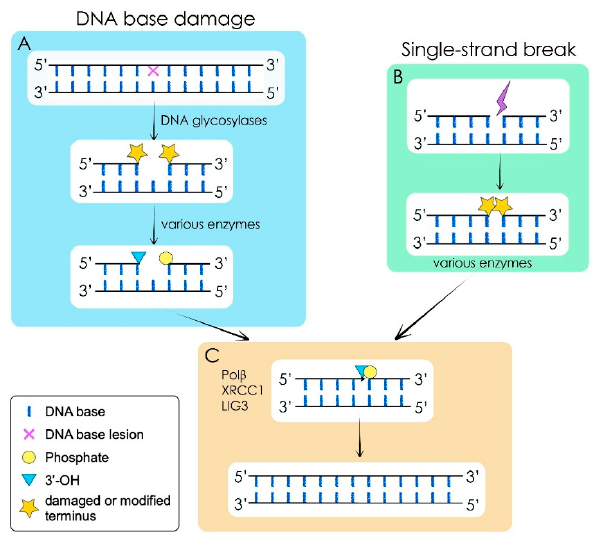
Figure 1. Simplified scheme of base excision repair (BER). Modified after [76,78]. ( A ) BER is initiated